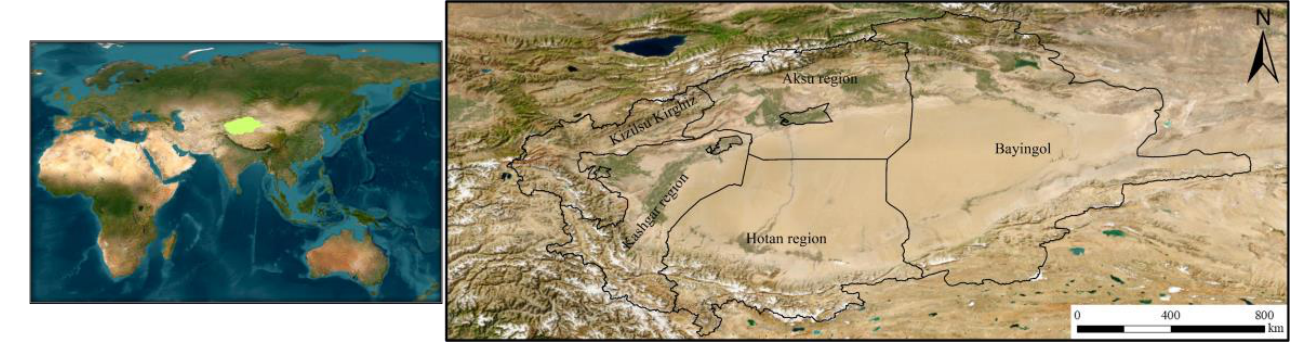
Figure 1. Sketch map of the Tarim River Basin (GS (2019) 1652) (http://www.resdc.cn (accessed on 6 March 2023).